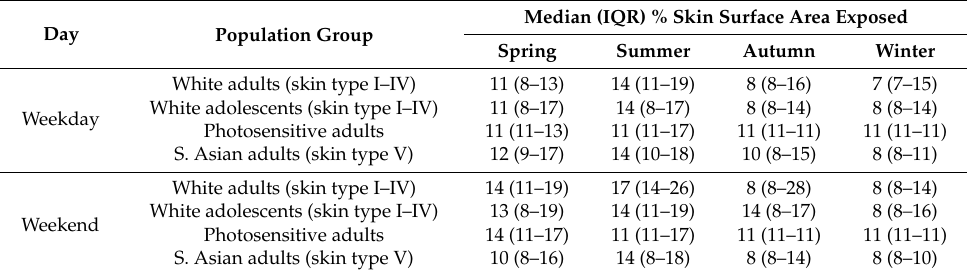
Table 3. Percentage of skin surface area exposed during study weeks.